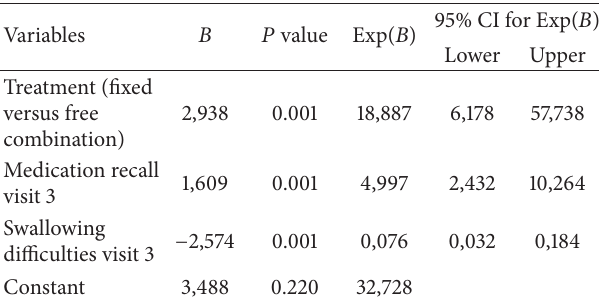
Table 3: Log regression model on compliance and confounding fac-